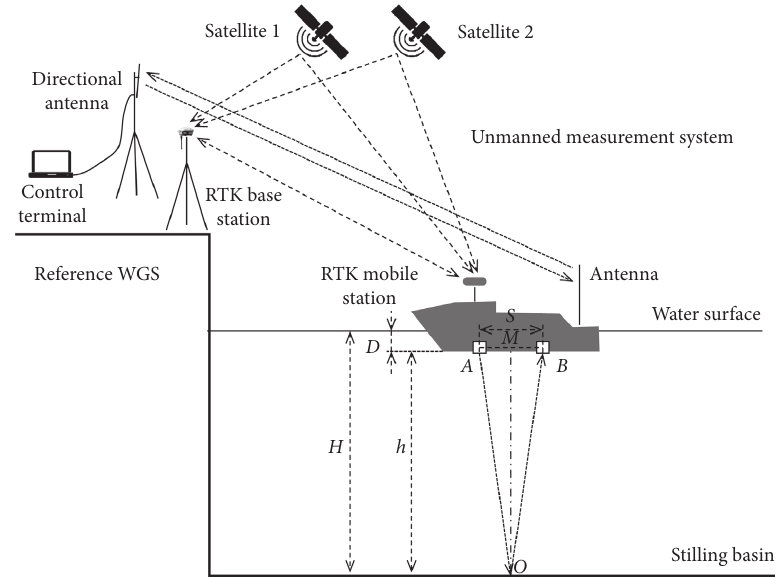
Figure 3: The diagram of unmanned survey system for underwater topography of the stilling